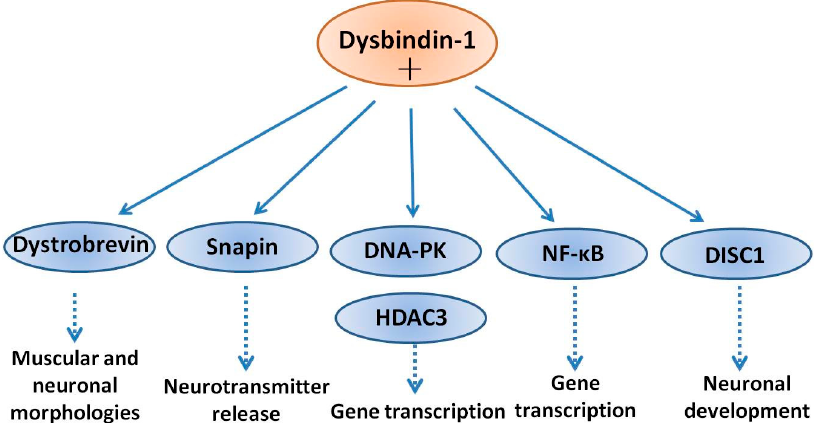
Figure 1. Interaction of dysbindin-1 with cellular proteins. Dysbindin-1 has been shown to associate into complexes with multiple binding partners, in both the cytoplasm and nucleus. Dysbindin-1 binds to α - and β -dystrobrevins and regulates muscular and neuronal morphologies. Dysbindin-1 may also interact with snapin and disrupted in schizophrenia 1 (DISC1), and thereby modulating neurotransmitter release and neurodevelopment, respectively. In the nucleus, dysbindin-1 can form a complex with DNA-dependent protein kinase (DNA-PK) and promote the phosphorylation of histone deacetylase 3 (HDAC3). In addition, interaction of dysbindin-1 with DISC1 may dysregulate neuronal development.